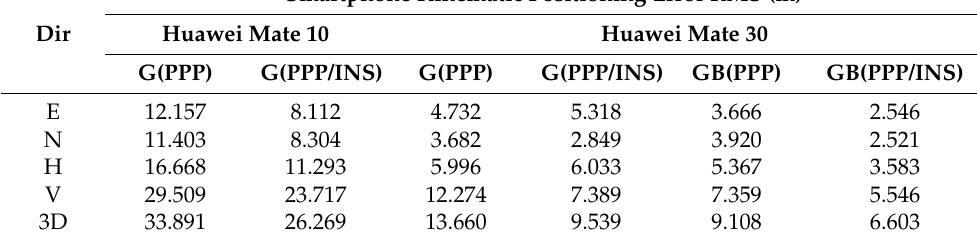
Figure 13a. In Table 2, the RMS of Mate 30 GPS/BDS PPP/INS horizontal errors decreases by 33.24% from 5.367 to 3.583 m, and the maximum horizontal positioning error decreases from 15.041 to 7.294 m. The RMS of Mate 30 GPS/BDS PPP/INS vertical errors decreases by 24.64% from 7.359 to 5.546 m. Previously, the average C/N 0 value observed on the west side of the playground was significantly lower than that on the east side, as shown in Figure 4a. Comparing the PPP solutions on the west and east sides of the playground, the RMS of Mate 30 GPS/BDS PPP horizontal errors on the west side is 6.515 m, which is 27.17% higher than the 5.123 m on the east side. Table 2. RMS of GNSS PPP and PPP/INS positioning error using smartphones on the playground. Dir denotes direction. G and B denote GPS and BDS, respectively. H, V, and 3D denote horizontal, vertical, and three-dimensional. Smartphone Kinematic Positioning Error RMS (m) Dir Huawei Mate 10 Huawei Mate 30